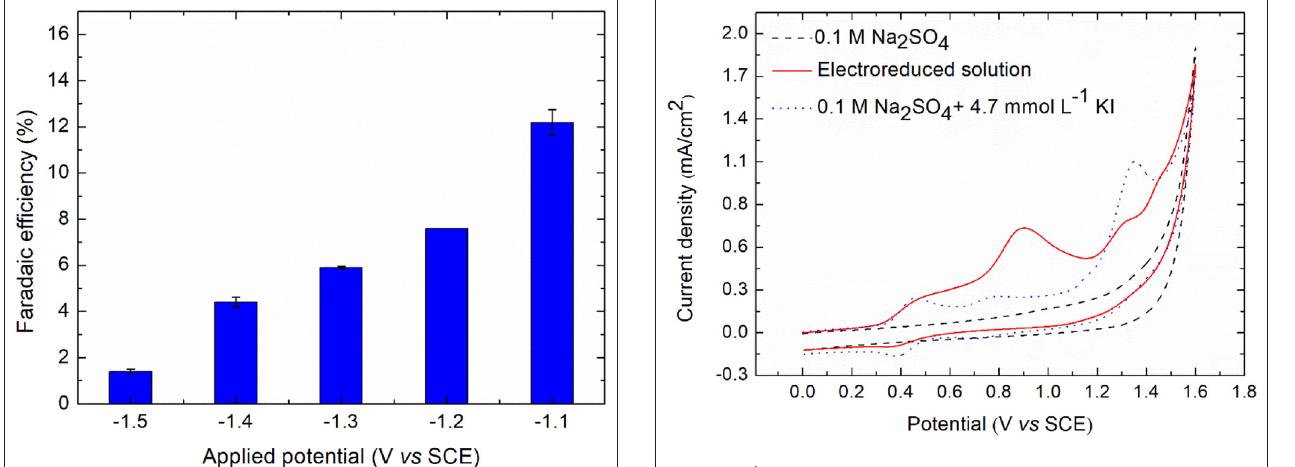
FIGURE 7 | Cyclic voltammetry of electrolytic medium after electroreduction and of potassium iodide for comparison on glassy carbon electrode. Scan rate: 0.1V s − 1